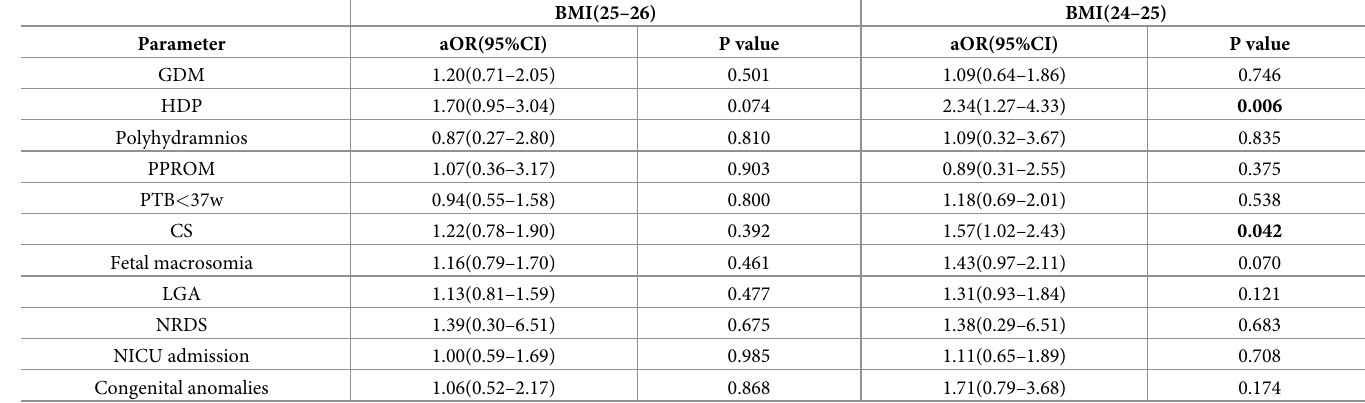
Table 8. Comparisons of adverse perinatal outcomes between target BMI group (BMI of 28–29) and BMI reduction